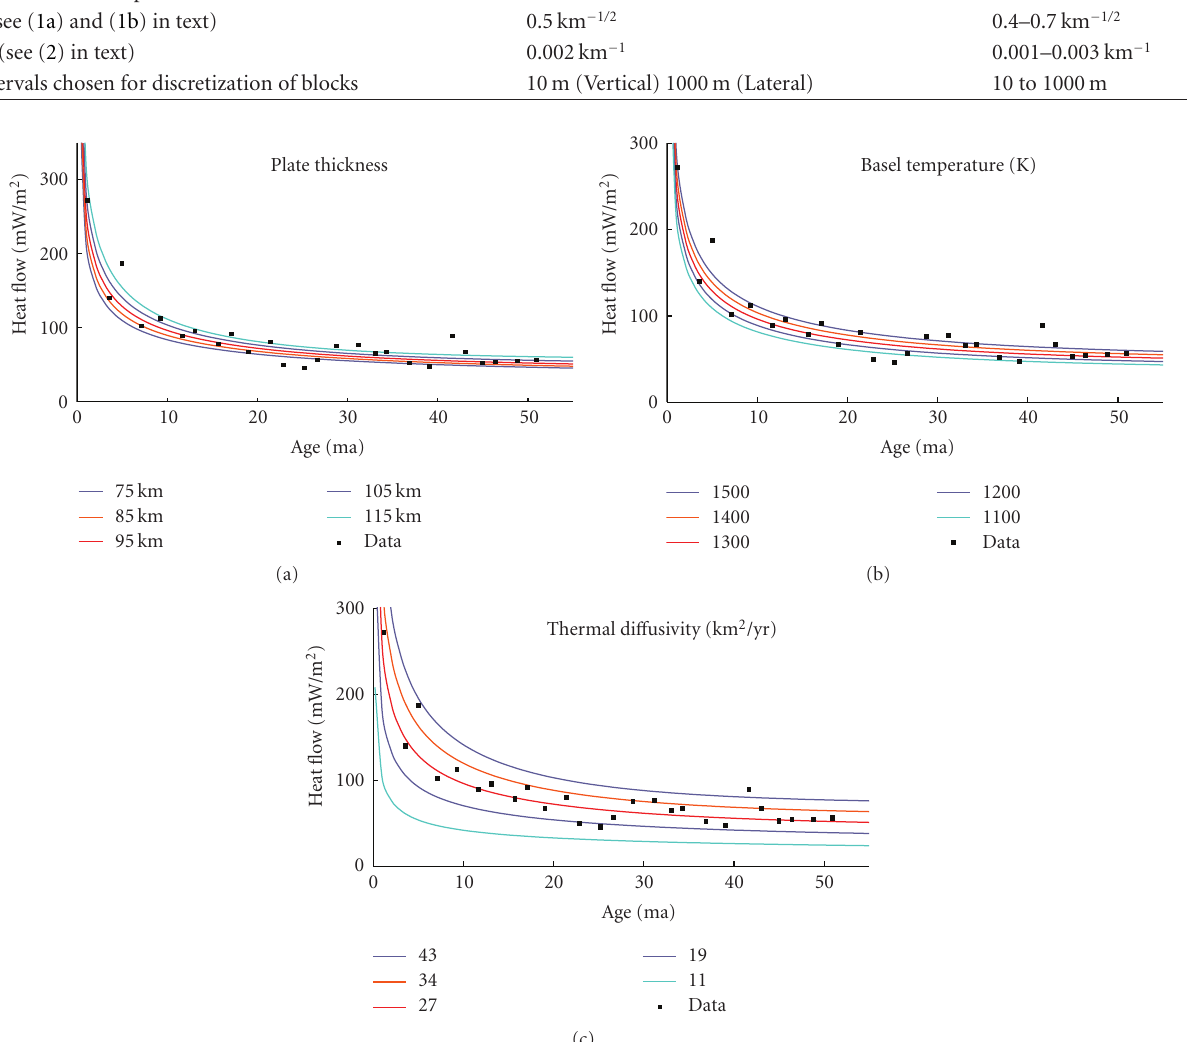
Figure 5: Results of numerical simulations illustrating the dependence of VBA model response to changes in the values assumed for plate thickness (a), basal temperatures (b) and thermal di ff usivity (c). The dark squares are the mean oceanic heat flow values.